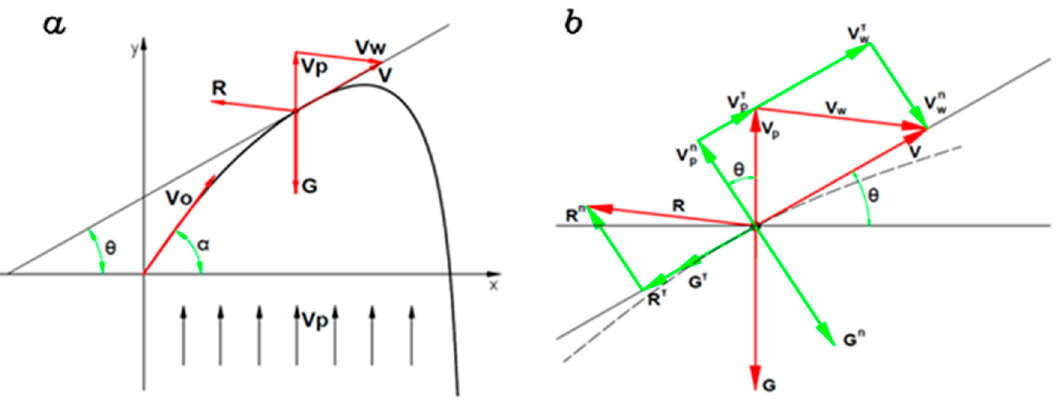
Figure 4. Movement of a particle in a vertical stream of air, displaying ( a ) particle trajectory and ( b ) the vector components of forces and velocities. The dashed line denotes the particle trajectory.